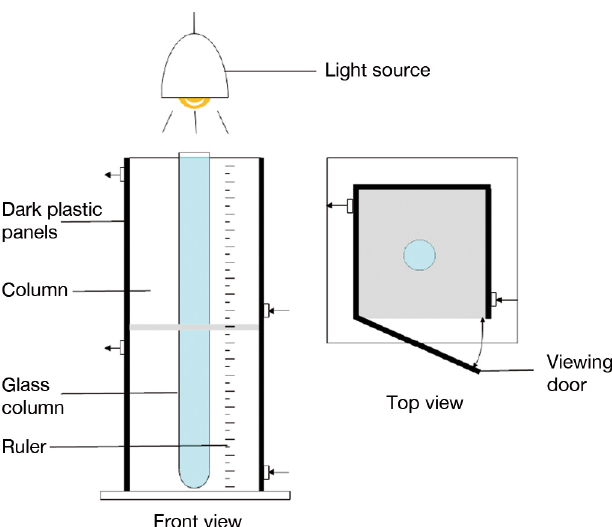
Fig. 1. The 80 cm column used in Expt 1 to test the vertical dis- tribution of Lepeophtheirus salmonis nauplii and copepodids under different conditions. A glass column (diameter: 5 cm; height: 85 cm) was positioned in the centre of a chamber split into 2 sections (20 × 20 × 42 cm), each with an input and out- put for water to continuously flow. This ensured water within the glass column remained at a constant temperature without creating internal turbulence. Arrows indicate flow direction in the outer chamber. Thick black lines: plastic panels (5 mm) used to surround the column; front panel was at tached with a hinge to allow easy view when tests ended. Light source was suspended 20 cm above the